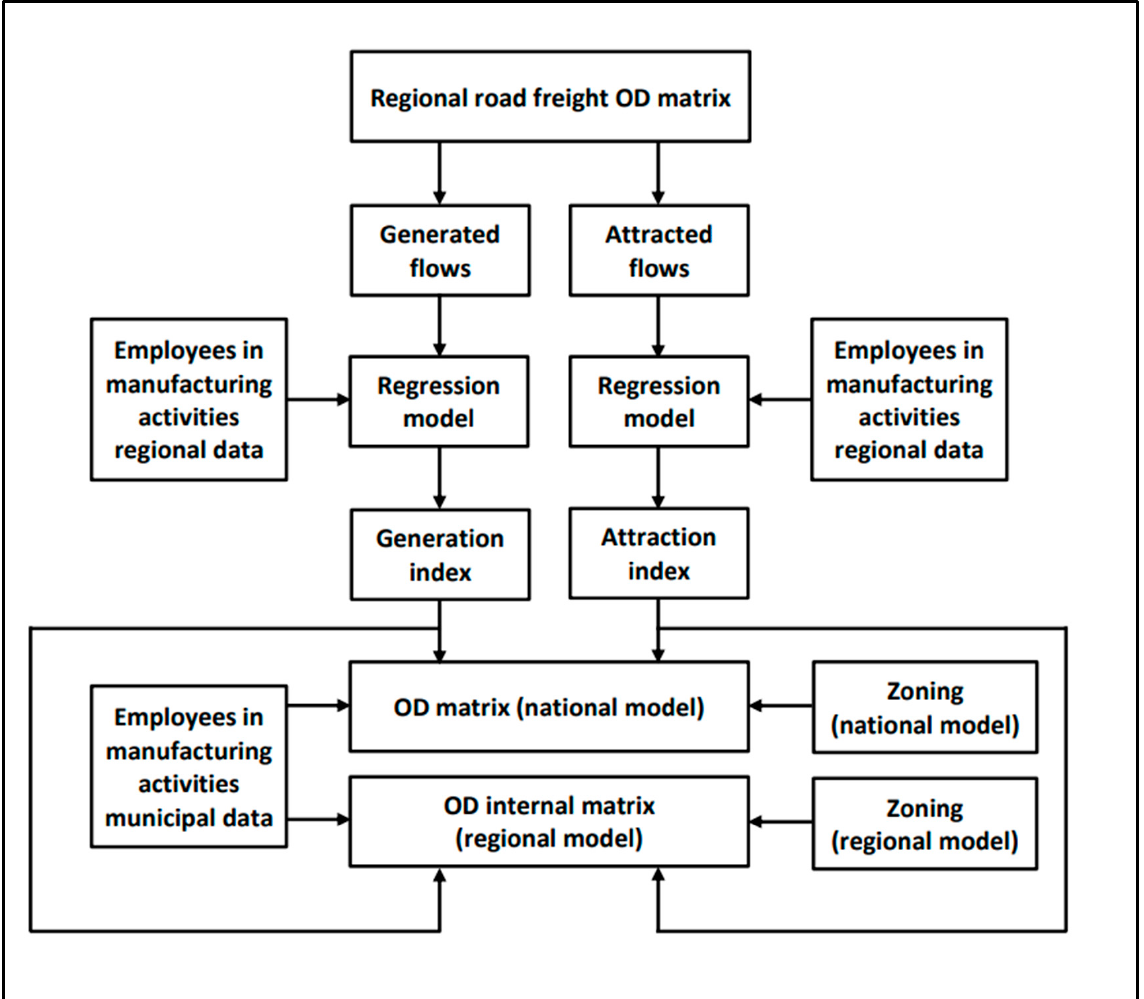
Figure 2. Procedure—Phase 1: national OD matrix and regional OD internal matrix.